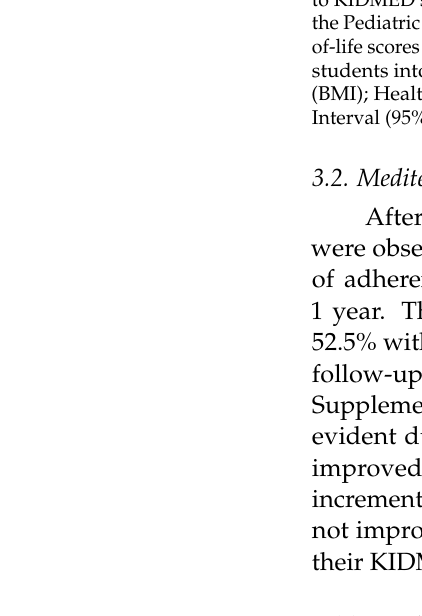
Table 4. Changes in students’ level of adherence to the Mediterranean diet and parent-perceived quality of life from baseline to follow-up evaluation according to sociodemographic characteristics of students and their